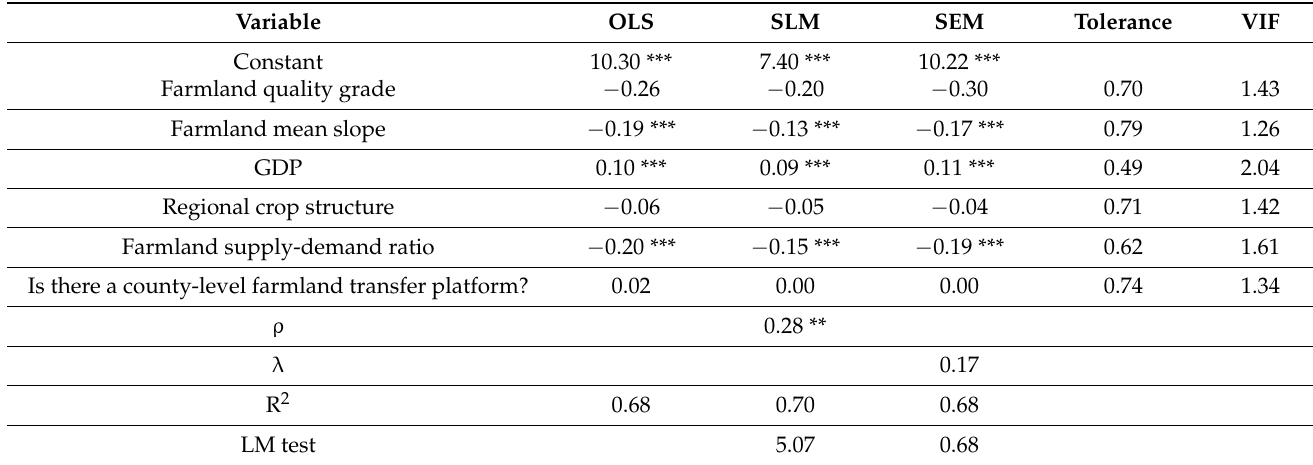
Table 4. Analysis results of the spatial econometric